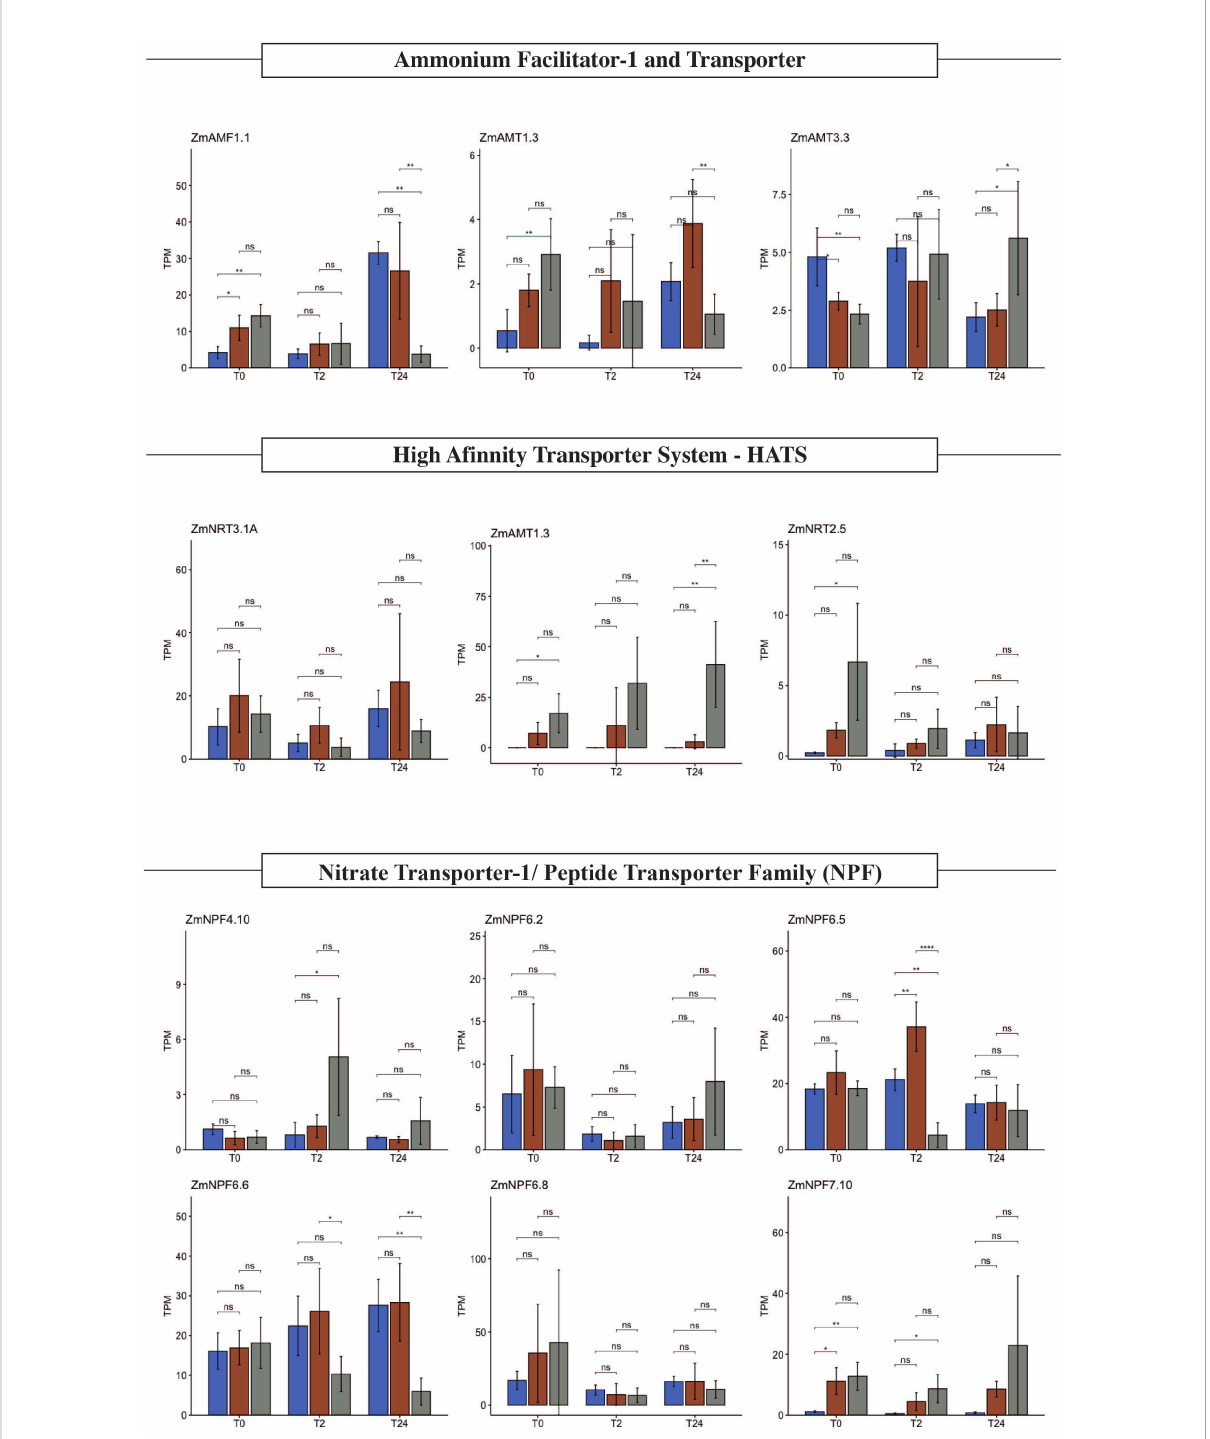
FIGURE 5 Nitrate, ammonium, and other nitrogen transporters expression pro fi le. Expression value in transcripts per million (TPM) of two selected ammonium transporters (AMT), two ammonium facilitator 1 (AMF-1), nine nitrate transporters from nitrate and peptide transporter family (NPF), and high-af fi nity system transporters family (HATS) in Z. mays B73 (blue), Sierra Mixe (SM) stage 1 (orange), and Sierra Mixe stage 2 (gray) at zero (T0), two (T2), and twenty-four (T24) hours after adding water. Analysis of variance (ANOVA) was performed on TPM values, and signi fi cance difference represents *p < 0.05; **p<0.01; ****p<0.0001. ns stands for non-signi fi